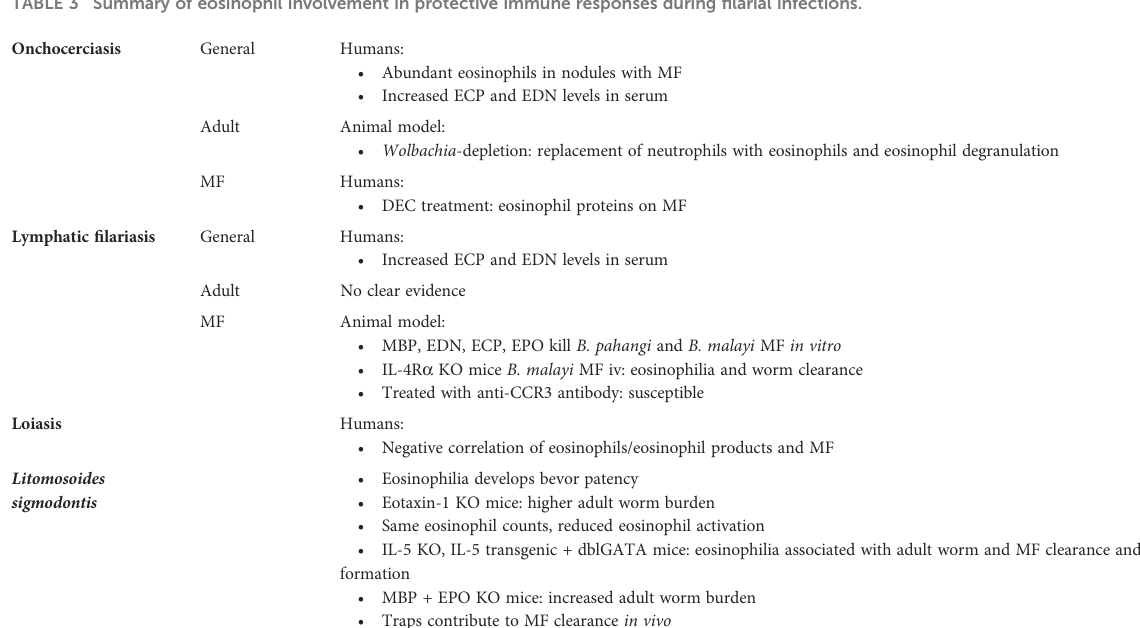
TABLE 3 Summary of eosinophil involvement in protective immune responses during fi larial infections.